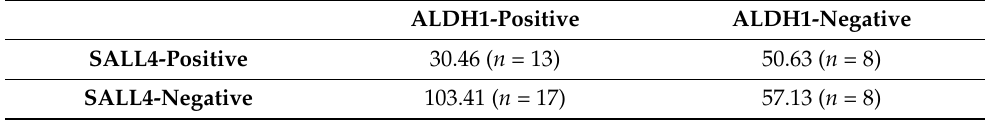
Table 2. Comparative analysis of the cluster number and ALDH1 and/or SALL4 positive and negative cells in patients with MPE.